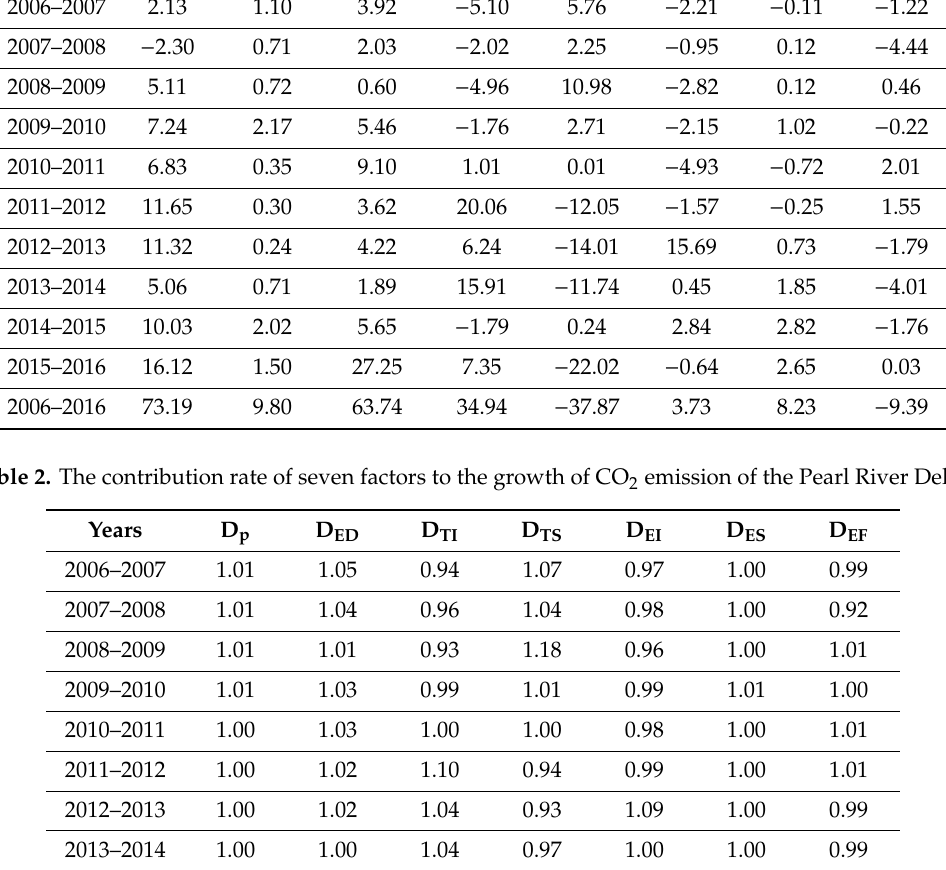
Table 1. The contribution value of seven factors to the growth of CO 2 emissions of the Pearl River Delta. Years